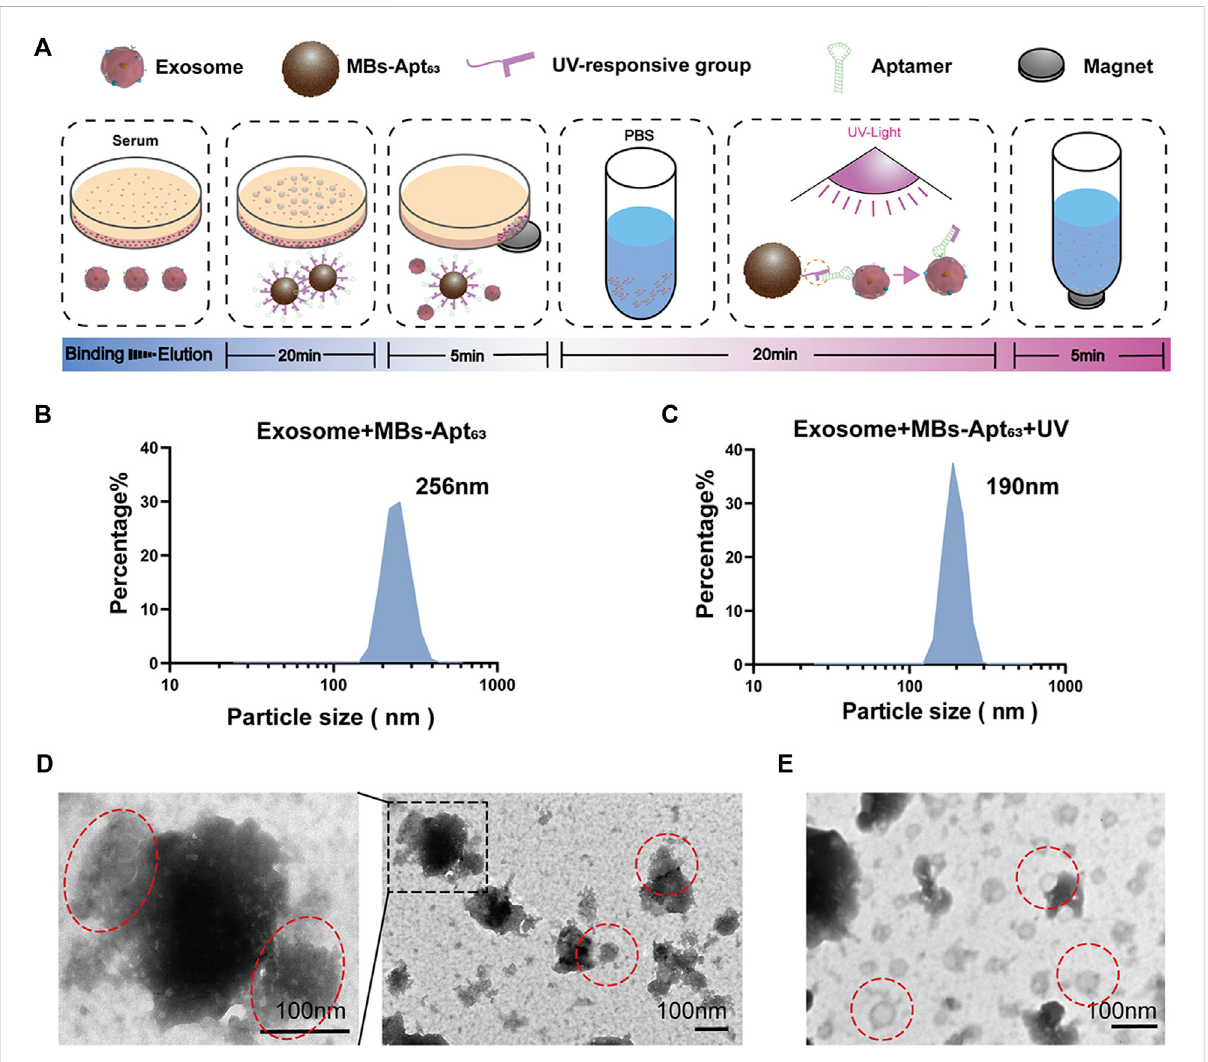
FIGURE 4 Capturing exosomes by and elution of exosomes from MBs-Apt 63 . (A) Schematic diagram for extracting exosomes from serum and cell supernatant with MBs-Apt 63 ; (B) DLS characterization after incubating exosomes with MBs-Apt 63 ; (C) DLS characterization after exposing the MBs- exosome complex to UV light; (D) Transmission electron microscopy image of exosomes bound to MBs-Apt 63 (left, 100000×, right, 25000×). Positions of exosomes and MBs-Apt 63 are marked in red; (E) Transmission electron microscopy image of exosomes eluted from MBs-Apt 63 by UV